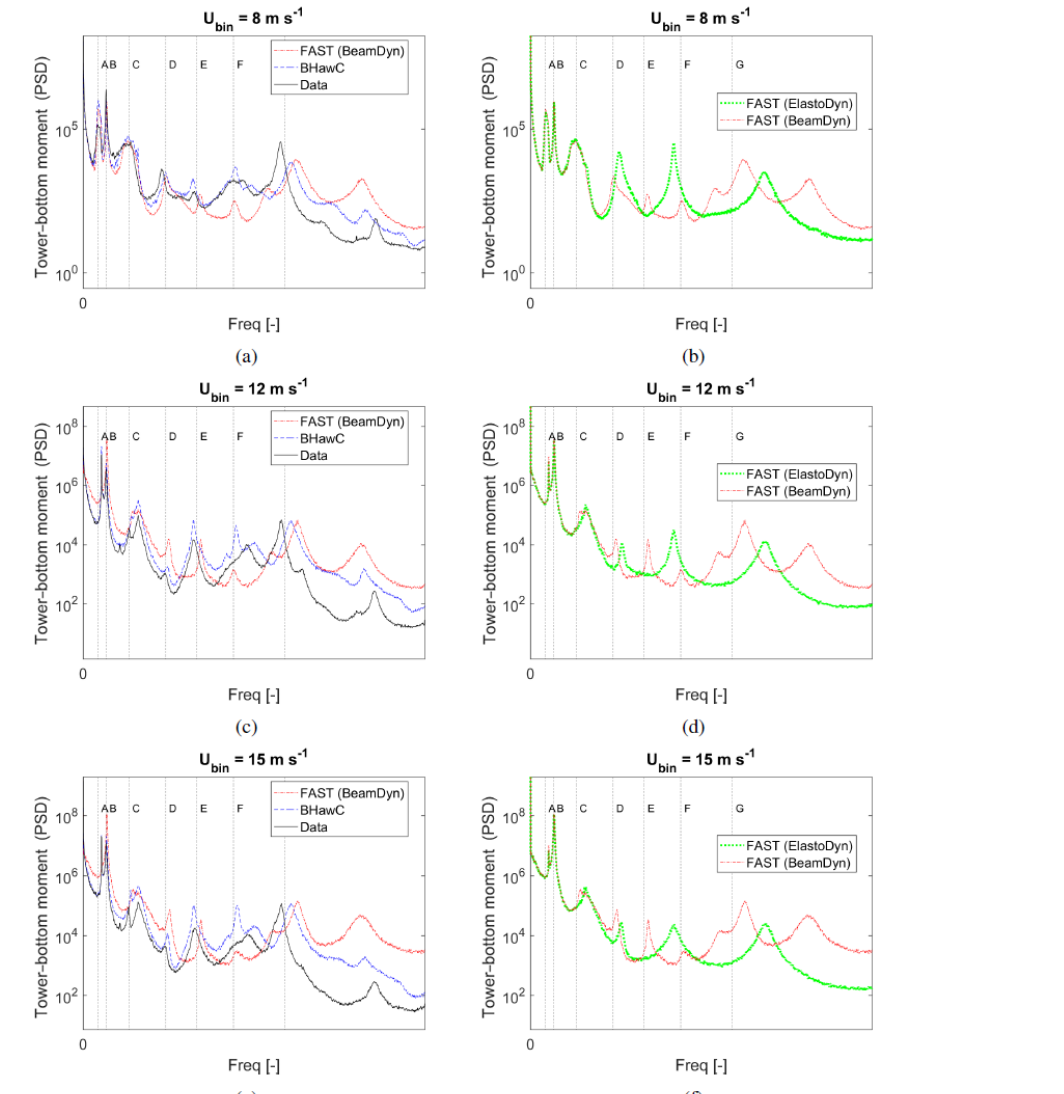
Figure 21. PSDs of the tower-bottom side–side bending moments. The three sets of graphs represent the ensemble-averaged PSDs from the inflow velocity bins at 8ms − 1 (top), 12ms − 1 (center), and 15ms − 1